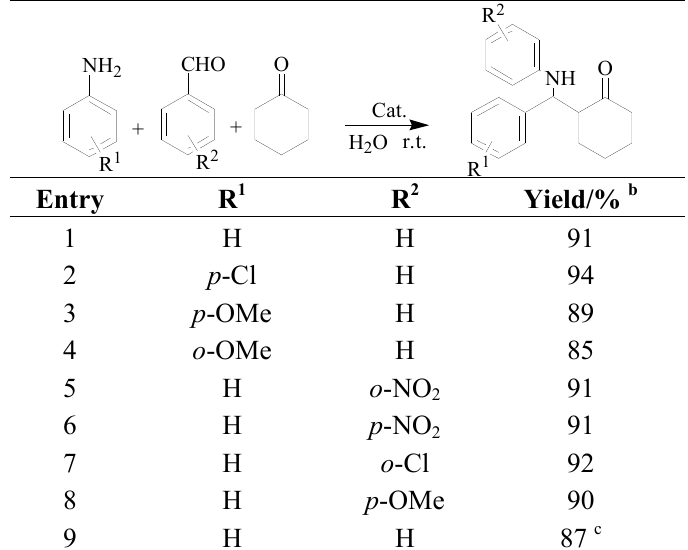
Table 3. Results of one-pot, three-component Mannich reactions with different substrates a catalyzed by GBAIL-C 14